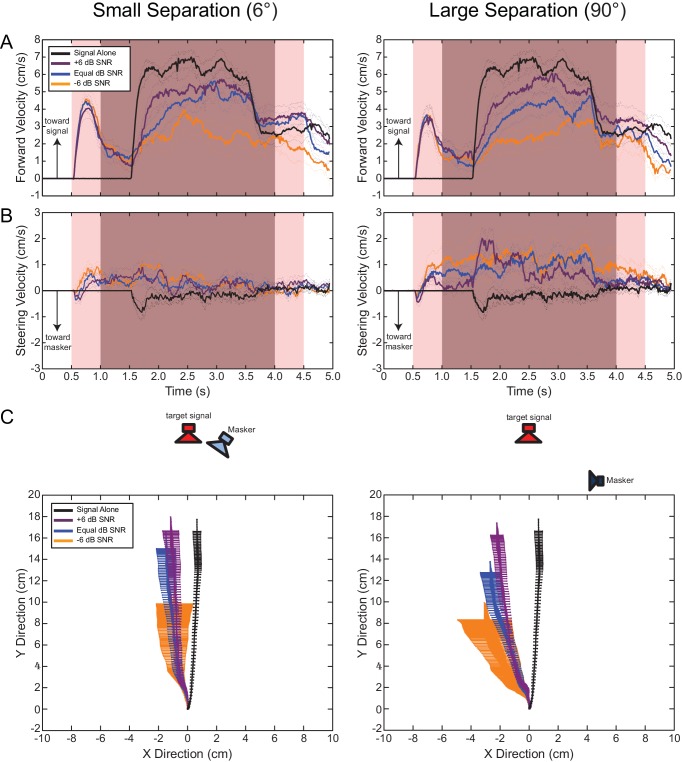
Effects of spatial separation and signal-to-noise ratio on sound localization.Mean (solid lines) and SEM (dotted lines) of (A) forward and (B) steering velocity components to a 76 dB SPL target signal alone (black trace) or signal and masker broadcasted at SNRs of −6 dB (orange trace), equal dB (blue trace),+6 dB (purple trace) from signal and masker with a 6° (left) or 90° (right) spatial separation. Light pink shaded areas indicate the duration of masker presentation. Dark pink shaded areas indicate the duration of the simultaneous presentation of signal and masker. At masker onset, flies responded with a brief walking component in the forward direction that quickly decayed. During this time frame, flies reactively steered to the masker, followed by steering movements away from the masker that were maintained for the remainder of stimulus presentation. Steering responses were minimally affected by SNR but were enhanced at greater signal and masker separation. At song onset, forward velocities increased to speeds well above responses to the masker onset. Average forward velocities depended on SNR but not signal and masker separation. Flies maintained steering away from the masker location. (C) Virtual walking trajectories in response to the target signal and masker separated by a 6° (left) or 90° (right) separation. Walking distance changed with SNR but not with signal and masker separation. The masker caused walking responses to be diverted away from the locations of the target signal and masker. With a 90° spatial separation walking responses were diverted even further in a direction contralateral to the masker location.DOI:
http://dx.doi.org/10.7554/eLife.20731.00910.7554/eLife.20731.010Figure 4—source data 1.Translational velocity in response to a target signal and masker separated by 6° and presented at different signal-to-noise ratios (SNRs).The target signal was presented at 76 dB SPL while the masker intensity was varied to achieve three SNRs (−6, 0, +6 dB). Masker presentation started and ended 0.5 and 4.5 s after the onset of data acquisition, respectively. Signal presentation started and ended 1.0 and 4.0 s after the onset of data acquisition, respectively. Data plotted in Figure 4A (left).DOI:
http://dx.doi.org/10.7554/eLife.20731.01010.7554/eLife.20731.011Figure 4—source data 2.Steering velocity in response to a target signal and masker separated by 6° and presented at different signal-to-noise ratios (SNRs).The target signal was presented at 76 dB SPL while the masker intensity was varied to achieve three SNRs (−6, 0, +6 dB). Masker presentation started and ended 0.5 and 4.5 s after the onset of data acquisition, respectively. Signal presentation started and ended 1.0 and 4.0 s after the onset of data acquisition, respectively. Data plotted in Figure 4B (left).DOI:
http://dx.doi.org/10.7554/eLife.20731.01110.7554/eLife.20731.012Figure 4—source data 3.Virtual walking path in response to a target signal and masker separated by 6° and presented at different signal-to-noise ratios (SNRs).The target signal was presented at 76 dB SPL while the masker intensity was varied to achieve three SNRs (−6, 0, +6 dB). ‘X’ and ‘Y’ coordinates of virtual walking paths measured from the treadmill system. Data plotted in Figure 4C (left).DOI:
http://dx.doi.org/10.7554/eLife.20731.01210.7554/eLife.20731.013Figure 4—source data 4.Translational velocity in response to a target signal and masker separated by 90° and presented at different signal-to-noise ratios (SNRs).The target signal was presented at 76 dB SPL while the masker intensity was varied to achieve three SNRs (−6, 0, +6 dB). Masker presentation started and ended 0.5 and 4.5 s after the onset of data acquisition respectively. Signal presentation started and ended 1.0 and 4.0 s after the onset of data acquisition, respectively. Data plotted in Figure 4A (right).DOI:
http://dx.doi.org/10.7554/eLife.20731.01310.7554/eLife.20731.014Figure 4—source data 5.Steering velocity in response to a target signal and masker separated by 90° and presented at different signal-to-noise ratios (SNRs).The target signal was presented at 76 dB SPL while the masker intensity was varied to achieve three SNRs (−6, 0, +6 dB). Masker presentation started and ended 0.5 and 4.5 s after the onset of data acquisition respectively. Signal presentation started and ended 1.0 and 4.0 s after the onset of data acquisition, respectively. Data plotted in Figure 4B (right).DOI:
http://dx.doi.org/10.7554/eLife.20731.01410.7554/eLife.20731.015Figure 4—source data 6.Virtual walking path in response to a target signal and masker separated by 90° and presented at different signal-to-noise ratios (SNRs).The target signal was presented at 76 dB SPL while the masker intensity was varied to achieve three SNRs (−6, 0, +6 dB). ‘X’ and ‘Y’ coordinates of virtual walking paths measured from the treadmill system. Data plotted in Figure 4C (right).